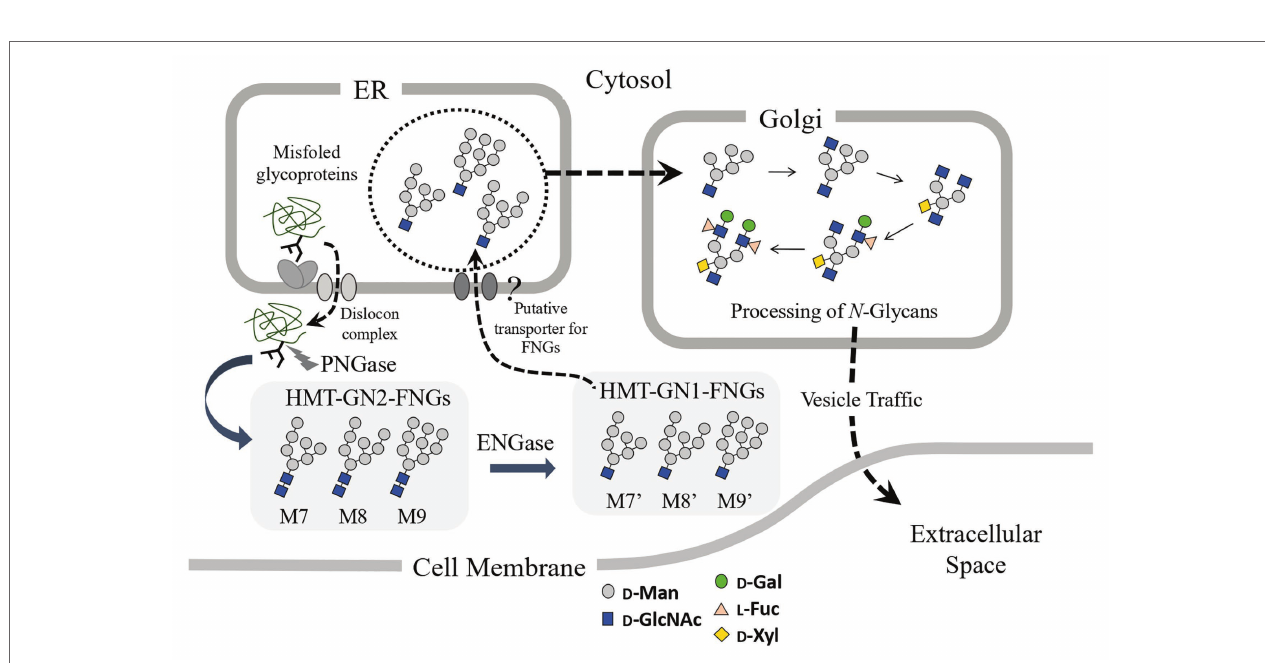
FIGURE 4 | Schematic representation of the putative processing and secretion pathway of plant complex type (PCT)-GN1-FNGs based on the structural features of high-mannose type (HMT)-GN1-FNGs found in pumpkin microsomes is shown. The putative transporter for the HMT-GN1-FNGs produced from the HMT-GN2- FNGs in the cytosol by ENGase has not yet been